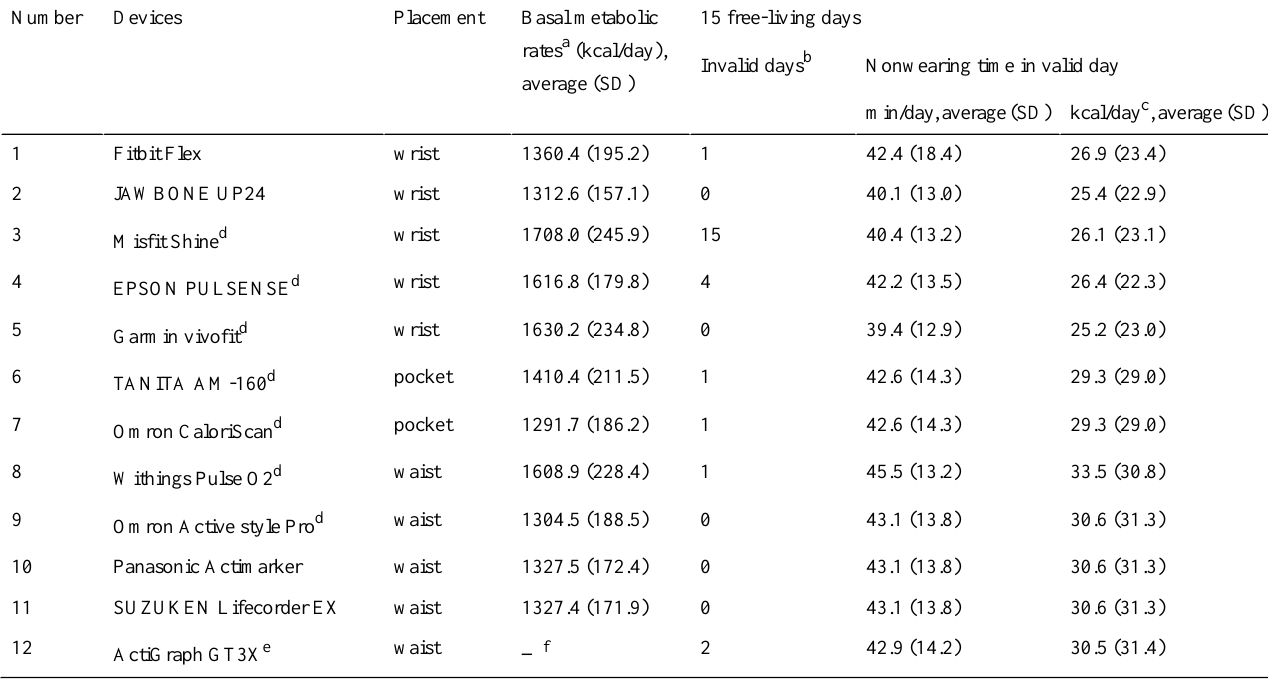
Table 1. Wearable devices used in the present study, basal metabolic rates extracted from each device, and information about invalid days and non-wearing time in 15 free-living